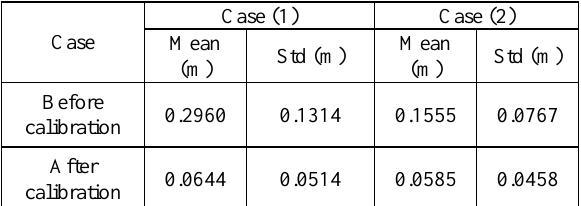
(a). The point clouds constructed from the images and the registered LIDAR using the estimated calibration parameters (b). The point clouds constructed from the images and the LIDAR before calibration